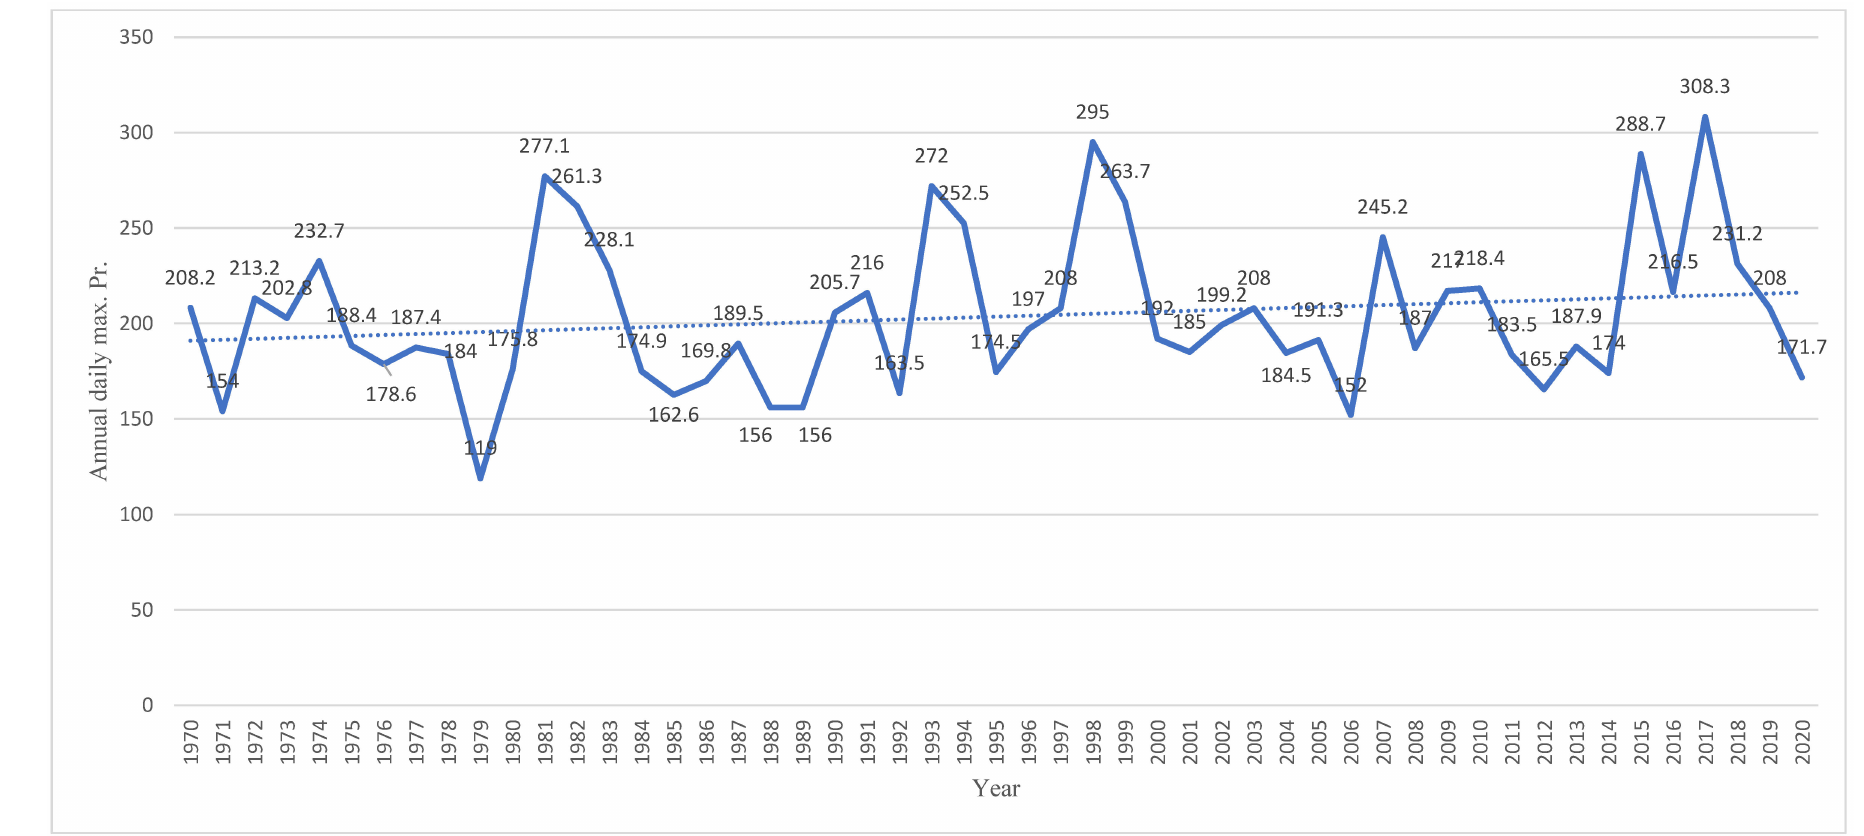
Figure A14. Observed annual daily maximum precipitation of Lumle,